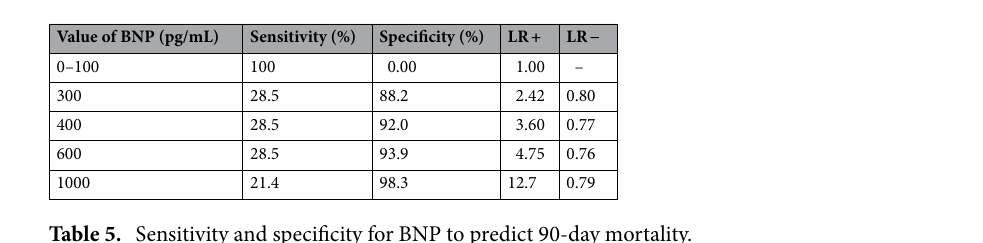
Table 5. Sensitivity and specificity for BNP to predict 90-day mortality.